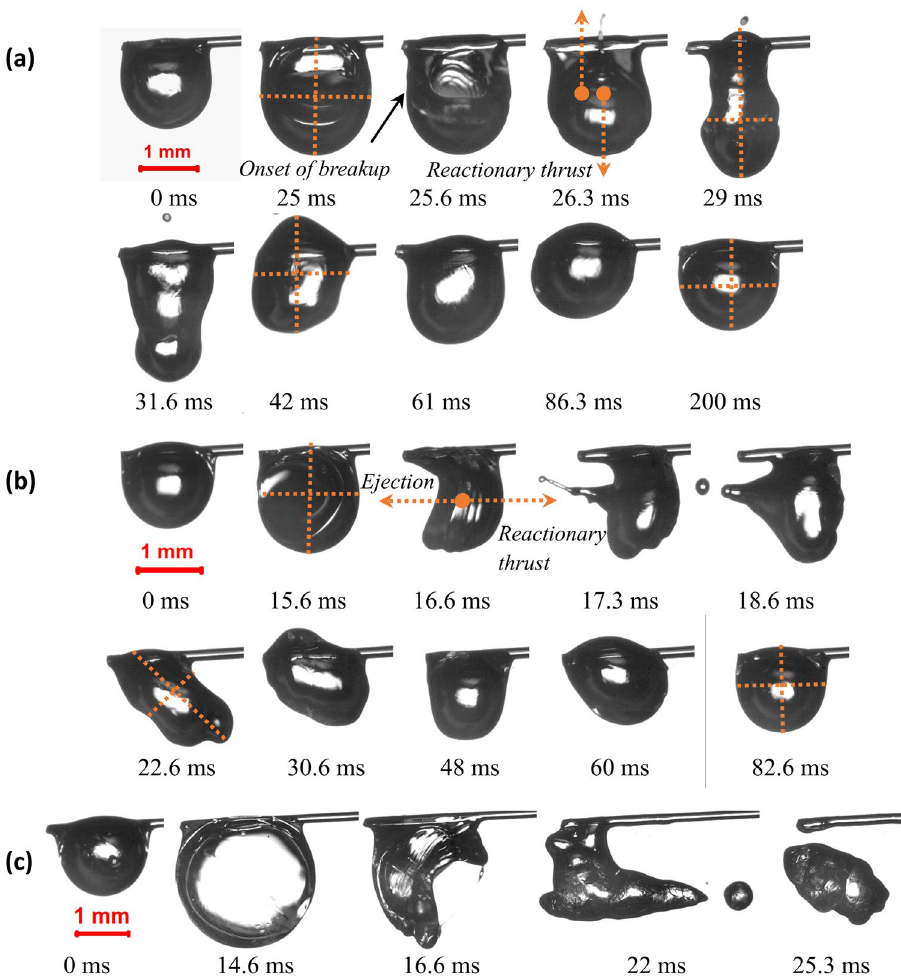
Figure 8. Shape deformations corresponding to the breakup of B30 ( α = 0.6), B50 ( α = 0.75), and E50 ( α = 3.77) droplets which represent ( a ) bubble breakup at the center of the droplet, ( b ) edge of the droplet and ( c )